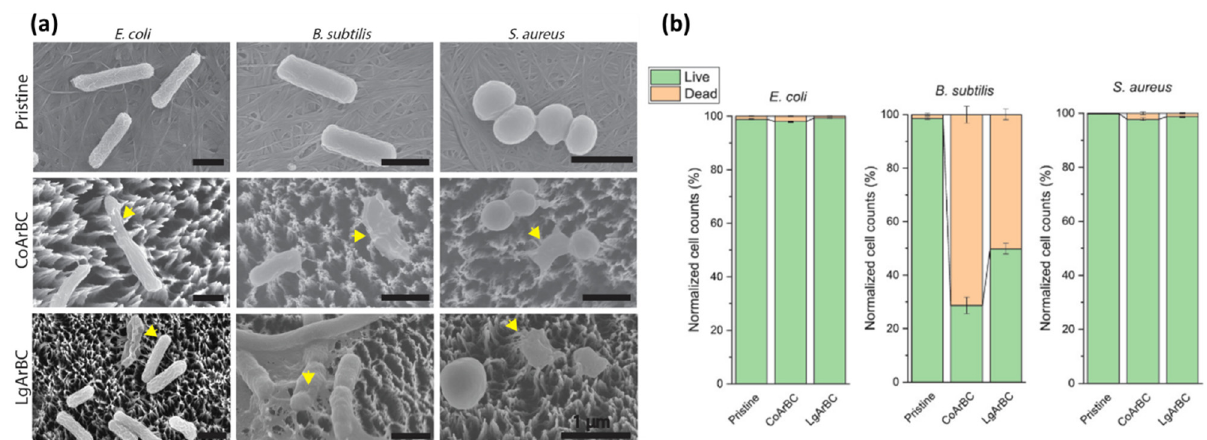
Figure 11. ( a ) SEM images of different bacteria after 1 h contact with untreated BC (first row), nanopatterned CoBC (second row), and nanopatterned LgBC (third row). Yellow arrows indicate the rupture points. ( b ) Quantification of live and dead cells of the different bacteria cultured on the different surfaces for 24 h. Reprinted with permission from Ref. [137]. Copyright 2020 American Chemical Society.